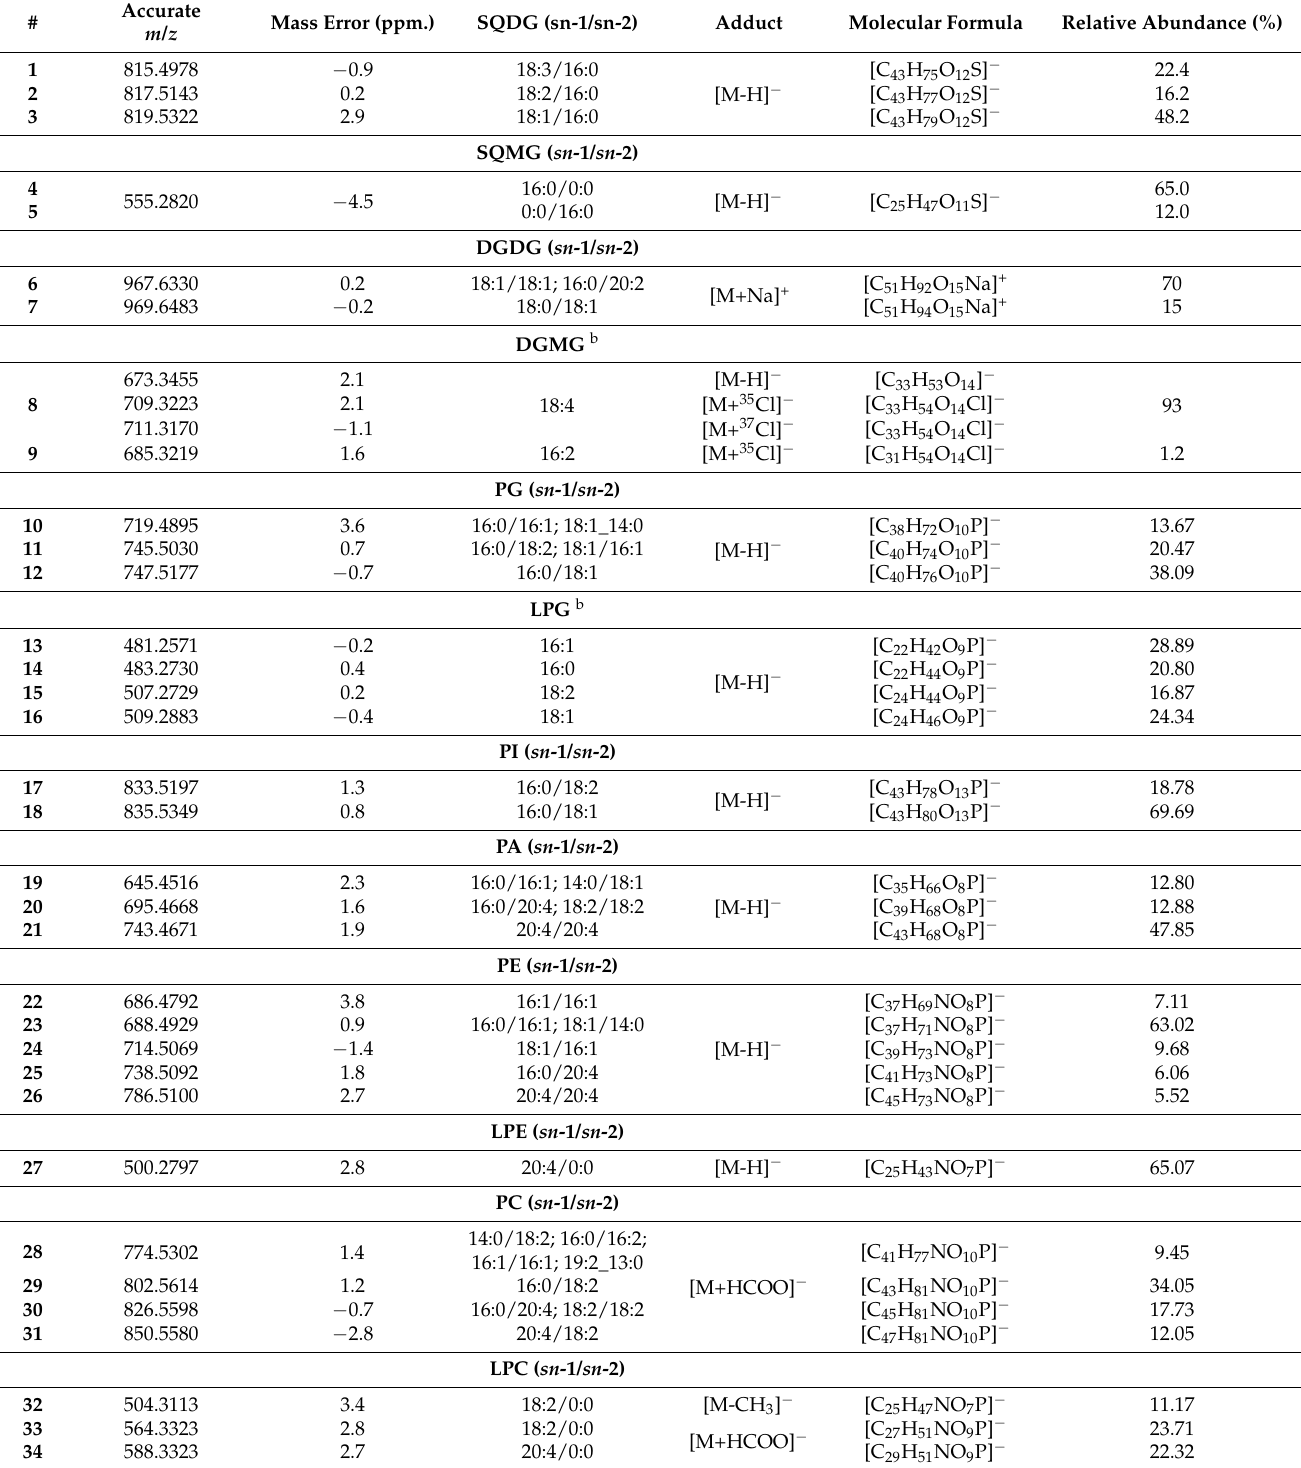
Table 1. List of the most abundant PL and GL species identified in the edible alga wakame a